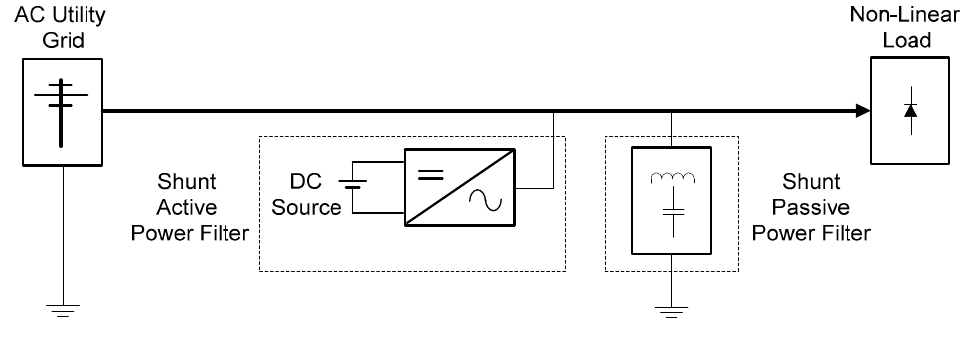
Figure 13. Circuit configurations of hybrid power filters.